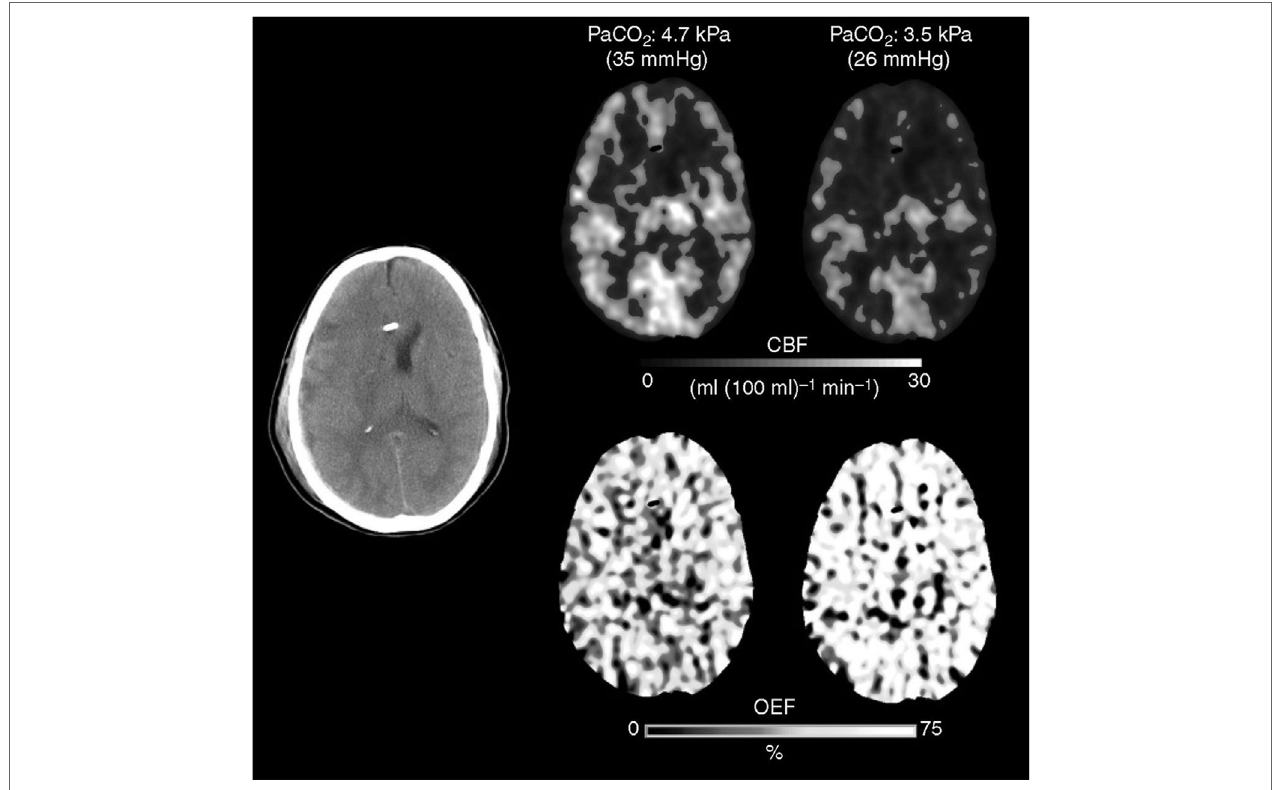
FiGURe 4 | The Xenon CT imaging that showed cerebral blood flow (CBF) decrease and O 2 extraction fraction (OEF) increase after